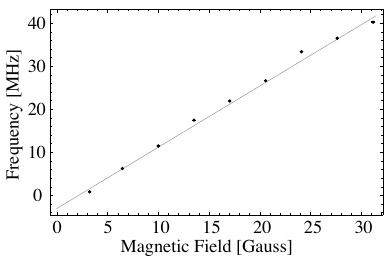
Figure 5. The frequency shift of the F = 3 → F (cid:48) = 4 transition as a function of magnetic field. The frequency shift is obtained by recording the position of the spectral line in a Rb cell placed in a magnetic field relative to the position of the spectral line without a magnetic field. A value of 1.49 ± 0.08 MHz/G for the Zeeman shift is found from the slope of a straight line fit. The expected value for the Zeeman shift of the m F = 3 → m F (cid:48) = 4 sublevel transition is 1.4 MHz/G. The horizontal error bars are estimated to be ± 5% and the vertical error bars are comparable to the size of the